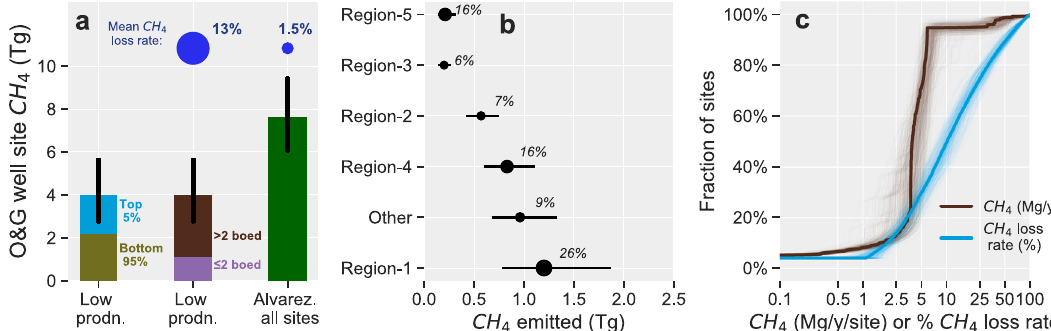
Fig. 4 National estimate of low production well site CH 4 emissions. a Comparison with Alvarez et al. 16 assessment of total national CH 4 emissions from all O&G production sites (Low prodn. = low production sites). Error bars represent the 95% con fi dence intervals (Methods). The blue bubbles represent the production-normalized CH 4 loss rates for low production well sites (this study) and for all O&G sites 16 . b Regional estimates of low production well site CH 4 emissions (see Fig. 1), with error bars representing the 95% con fi dence intervals on the mean (Methods). “ Other ” means total estimates for sites in other locations outside of regions 1 – 5 in Fig. 1. Symbols are sized by CH 4 loss rates relative to gross CH 4 production in each region, which are shown as % against each symbol. c Modeled distribution of mean site-level CH 4 emissions (brown lines) and CH 4 loss rates (blue lines). The thick solid lines represent the mean distribution while the thin lines are the results of the 500 simulated distributions for uncertainty assessment (Methods). For visualization, results are shown for the 99% of sites with modeled site-level emissions of up to 100 Mg/year and 100% CH 4 loss rates. Additional results in tabular form can be found in Supplementary Tables 5 – 7. 1 Mg = 1000